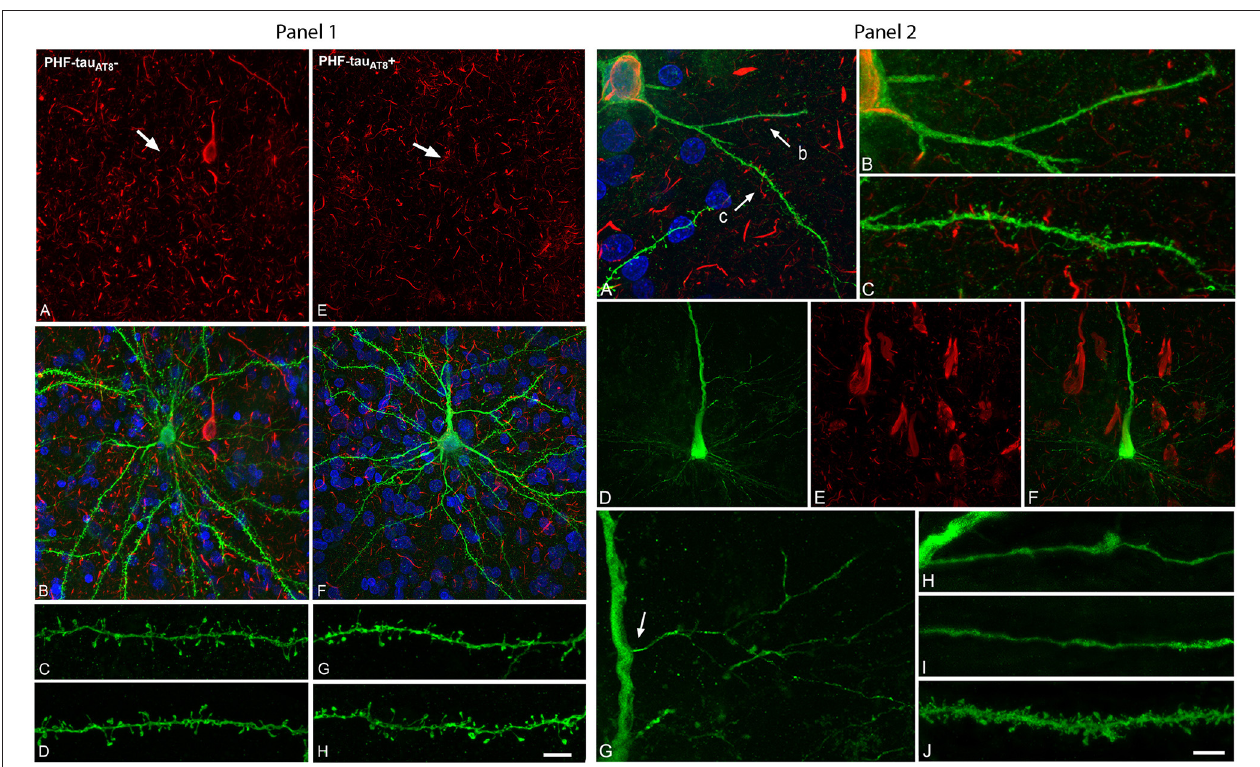
FIGURE 1 | Panel 1. Neurons and dendrites in the parahippocampal cortex of patient P9 injected with LY whose soma is free of phospho-tau PHF-tau AT8 -ir (PHF-tau − AT 8 ; A–D) or contains phospho-tau (PHF-tau + AT 8 in the putative pre-tangle state (Pattern I; E–H) . Stacks of 26 (A , B) and 28 (E,F) confocal optical sections, respectively, obtained after combining the channels acquired separately for DAPI (blue), LY (green), and PHF-tau AT8 immunostaining (red). Stacks of 26 (C,D) and (32 (G,H) confocal optical sections, respectively, from basal dendrites of PHF-tau − AT 8 (C,D) and immunostained (PHF-tau + AT 8 ; G,H) LY-injected pyramidal neurons . No changes were found in dendrite diameter or in the number, length or volume of the dendritic spines in neurons with Pattern I. Arrows in (A) and (E) indicate the localization of the cell body of the LY-injected pyramidal neurons shown in (B) and (F) , respectively. Scale bar in (H) : 13 µ m in (A,B,E , F) ; 2 µ m in (C,D,G , H). Taken from Merino-Serrais et al. (2013). Panel 2 . Alterations of dendrites and dendritic spines in LY-injected neurons with extensive neurofibrillary tangles (Pattern IIb of immunostaining), in the parahippocampal cortex in patient P9 (A–C) and in the CA1 of patient P12 (D–J) that were PHF-tau AT8 -ir or PHF-tau PHF 1 -ir, respectively. (A) , Stack of 27 confocal optical sections obtained after combining the channels acquired separately for DAPI (blue), LY (green), and PHF-tau AT8 -ir (red), showing the cell body and proximal dendrites of the intracellularly labeled neuron that contains phospho-tau. (B,C) , Higher magnification of (A) , showing the dendrites indicated as b and c, respectively. Note the low density of dendritic spines in dendrite b compared to dendrite c, as well as the low spine density in dendrite c compared to the dendrites in Panel 1 from neurons that are free of phospho-tau or that contain phospho-tau in the putative pre-tangle state. The dendritic spines are also notably smaller. (D–E) Stacks of 27 confocal optical sections showing the cell body and proximal dendrites of the intracellularly labeled neuron (D) that contains phospho-tau (E) . (F) Image obtained by combining panels (D) and (E) . (G) Higher magnification of (D) . (H , I) Stacks of 38–55 confocal optical sections from a collateral apical dendrite (arrow in G) of the LY-injected pyramidal neuron, showing different segments of the same dendrite (H , proximal; I , distant). (J) Stack of 26 confocal optical sections from the collateral apical dendrite of an intracellularly labeled neuron that was adjacent to the LY-injected neuron shown in (D) and that was free of phospho-tau. Note the lack of dendritic spines and the thin diameter of the dendrites of the neurons containing phospho-tau (H,I) compared to the dendrite of the neuron that was free of phospho-tau (J) . Scale bar in (J) : 10 µ m in (A); 3.5 µ m in (B,C) ; 20 µ m in (D–F) ; 9 µ m in (G) ; 4.5 in (H–J) . Taken from Merino-Serrais et al.